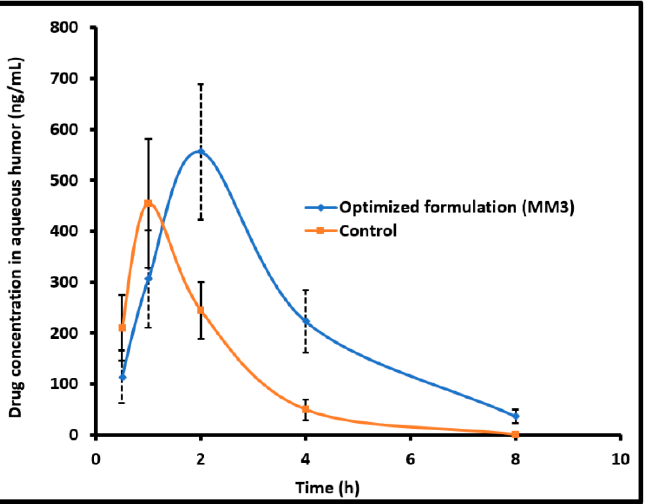
Figure 5. A comparative evaluation of moxifloxacin level in the aqueous humor of rabbits from optimized nanoemulsion and control (commercial moxifloxacin eye drops) with similar dose (adapted from [35], published by MDPI,